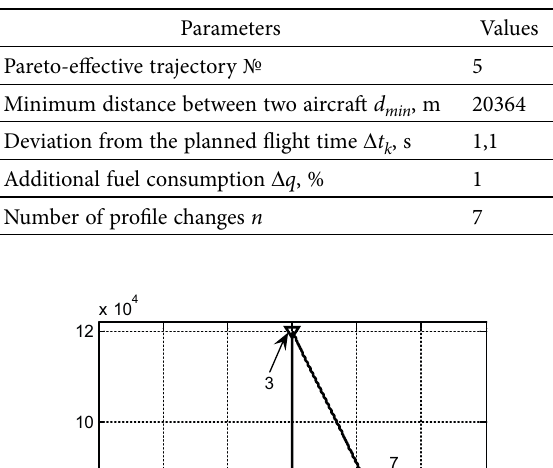
Fig. 3. The value of the objective function, ( ) function Table 3. Specified flight speeds